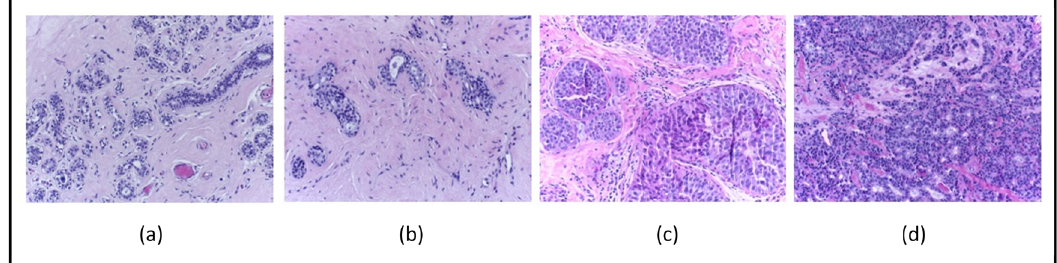
Figure 8: Samples from the BACH2018 dataset [ 91 ] . ( a ) Normal, ( b ) benign, ( c ) in situ , and ( d ) invasive.